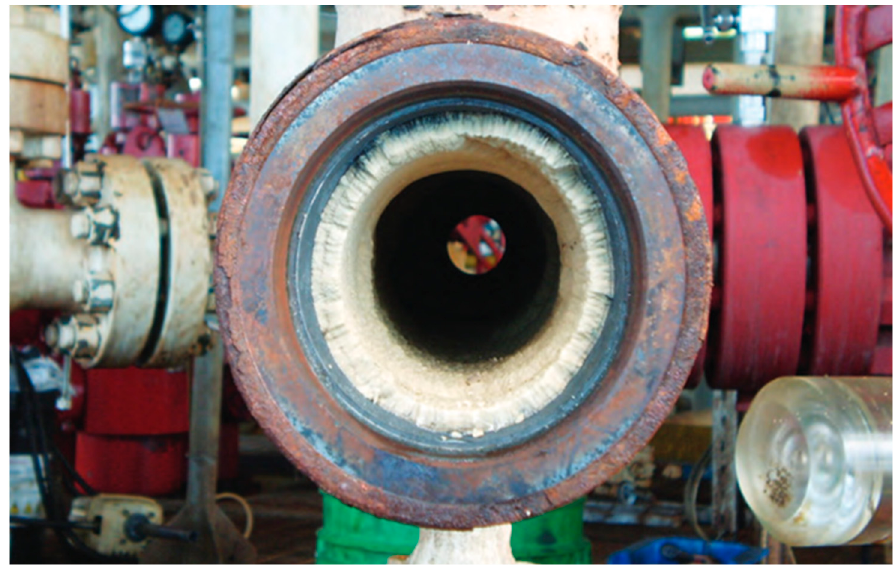
Figure 1. Example of scale deposition in a pipe.